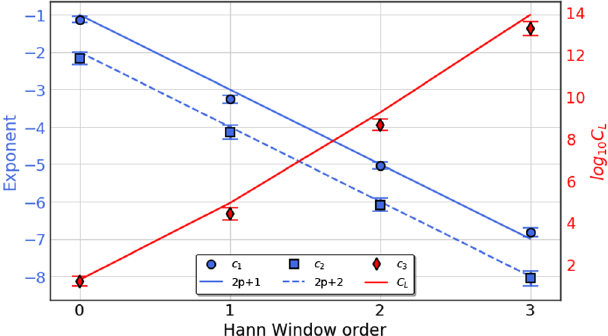
FIG. 7. The coefficients estimated from the fit of the tune error ϵ 1 to the surface of Eq. (37), along with their uncertainty. The c 1 coefficient is marked with blue circles, c 2 with blue squares, and c 3 with red diamonds. The error bars represent the 1 σ standard error of the fit. The theoretical predictions for the coefficients are shown with a blue dashed and thick line for c 1 and c 2 , respectively. The theoretical estimation of C red line.